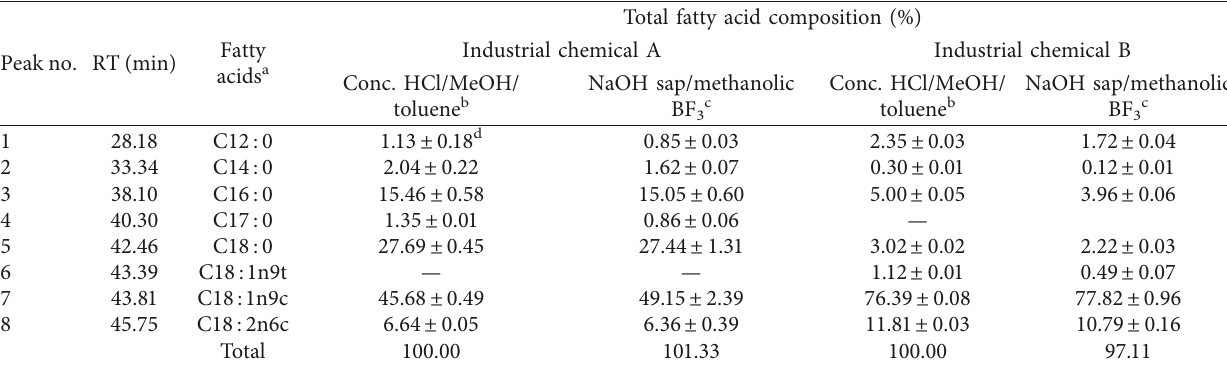
Table 3: Compositional characterization of two kinds of fatty acids zinc salts A and B by GC-MS analysis on their FAMEs prepared by the optimized conc. HCl/methanol/toluene method.